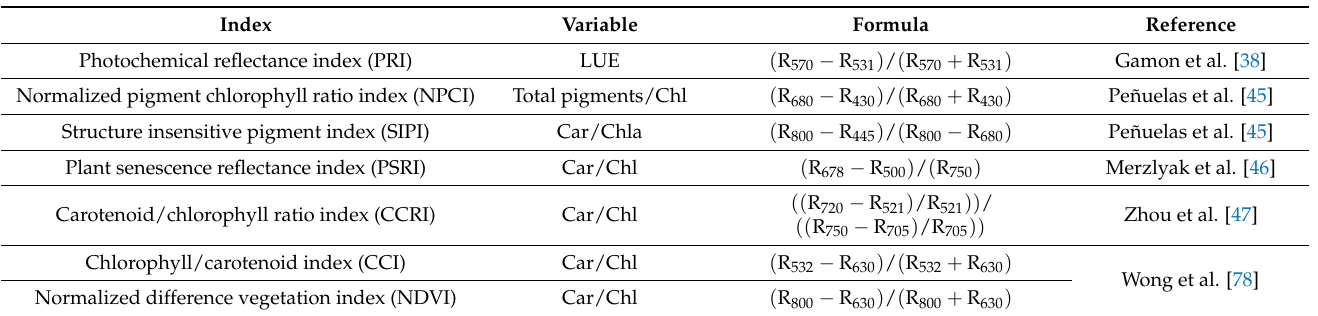
Table 1. Previously published spectral indices for the estimation of the chlorophyll (Chl)/carotenoid (Car) ratio in other